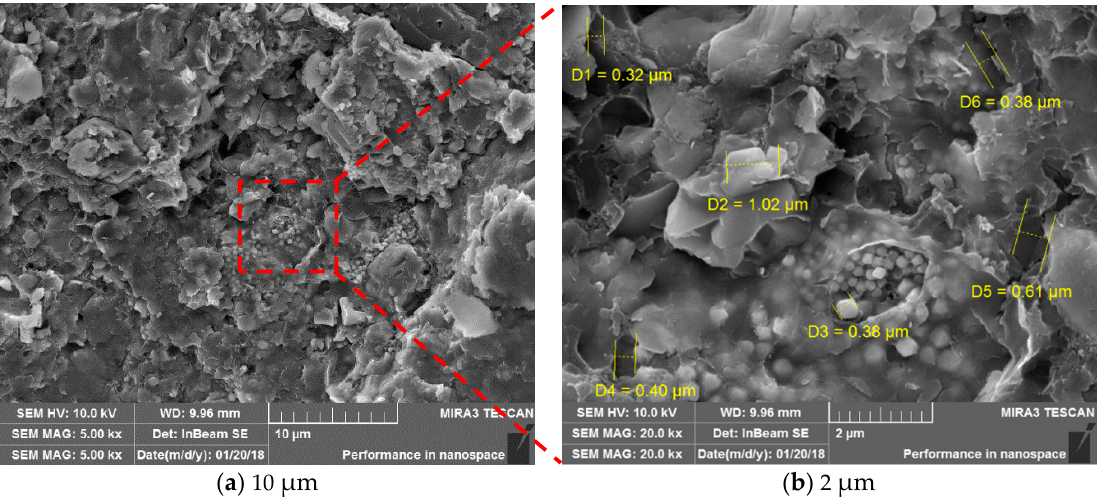
Figure 3. Scanning of microscopic electron microscopy at 10 and 2 μ m.